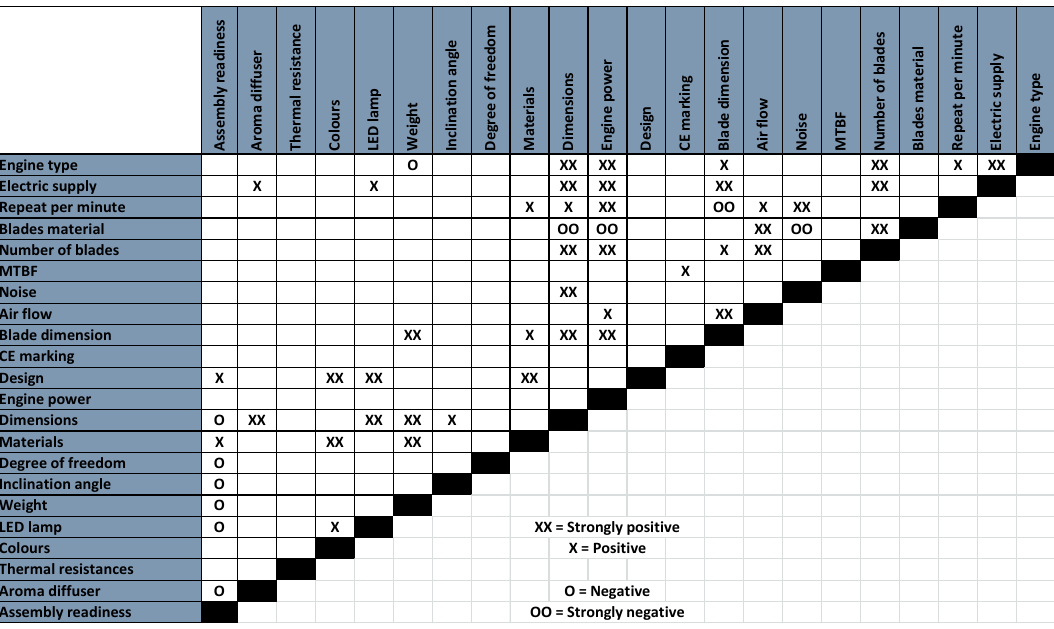
Figure. 7. Technical critical variables.